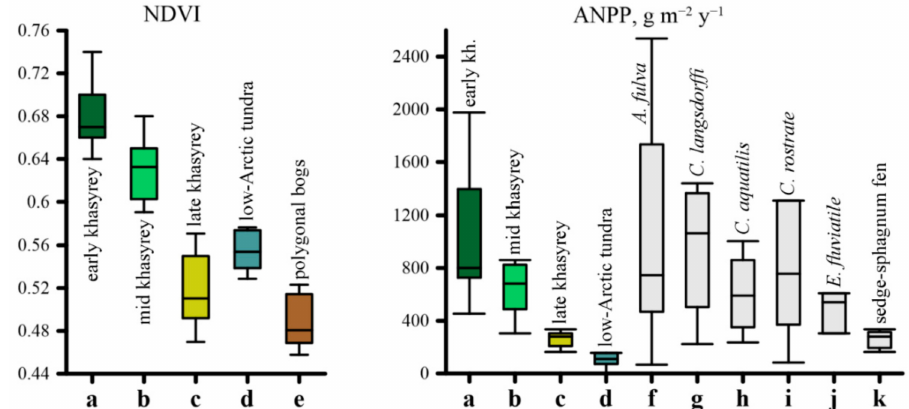
Figure 9. The variability of the aboveground net primary productivity and NDVImax (median, percentiles, minima and maxima) in khasyrey plant communities: a, b, c—early, mid and late stage successions of plant communities, respectively; d—plant communities of low-Arctic tundra (ANPP are taken from Bazilevich [67,68]); e—polygonal bogs; f, g, h, i, j—plant communities dominated by Arctophila fulva , Calamagrostis langsdor ffi , Carex aquatilis , Carex rostrate , Equisetum fluviatile ; k—sedge-cotton grass-sphagnum